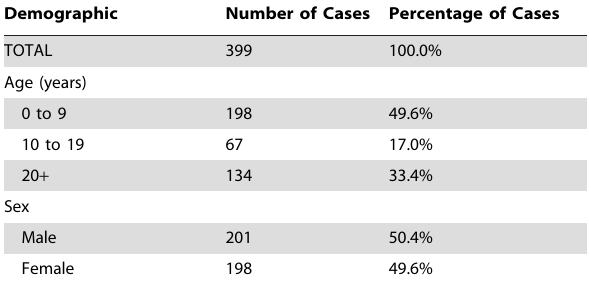
Table 1. Demographics of angular stomatitis cases